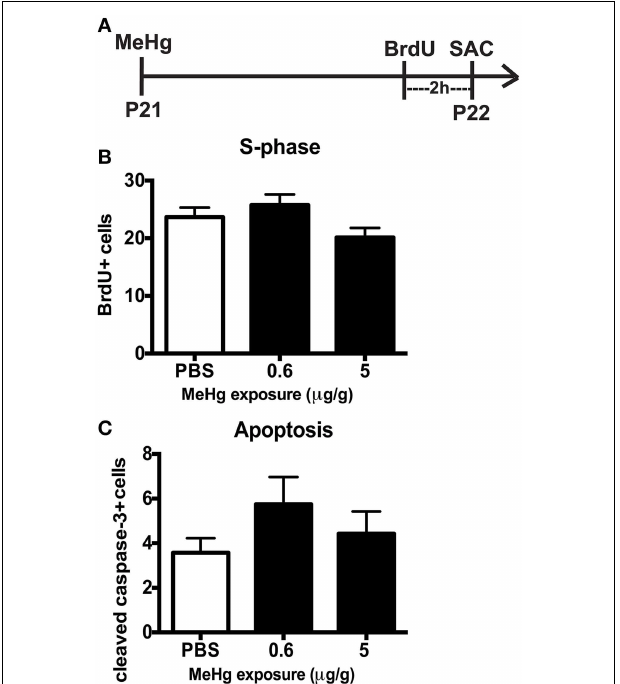
FIGURE 4 | The adolescent (P21) hippocampus is not vulnerable to 24h MeHg exposure. (A) Experimental timeline: P21 rats were given a single sc injection of MeHg (5 µ g/g) or vehicle (PBS) at 0h, and after an ip injection of BrdU at 22h, were sacrificed at 24h. Four (4) sections per brain were counted. (B) Quantification of the average number of BrdU + cells per section per animal in the hilus. Animals: n = 8 –9 per group. Each bar represents mean ± SEM. (C) Quantification of the average number of cleaved caspase-3 + cells per section per animal in the hilus. Animals: n = 7 –8 per group.